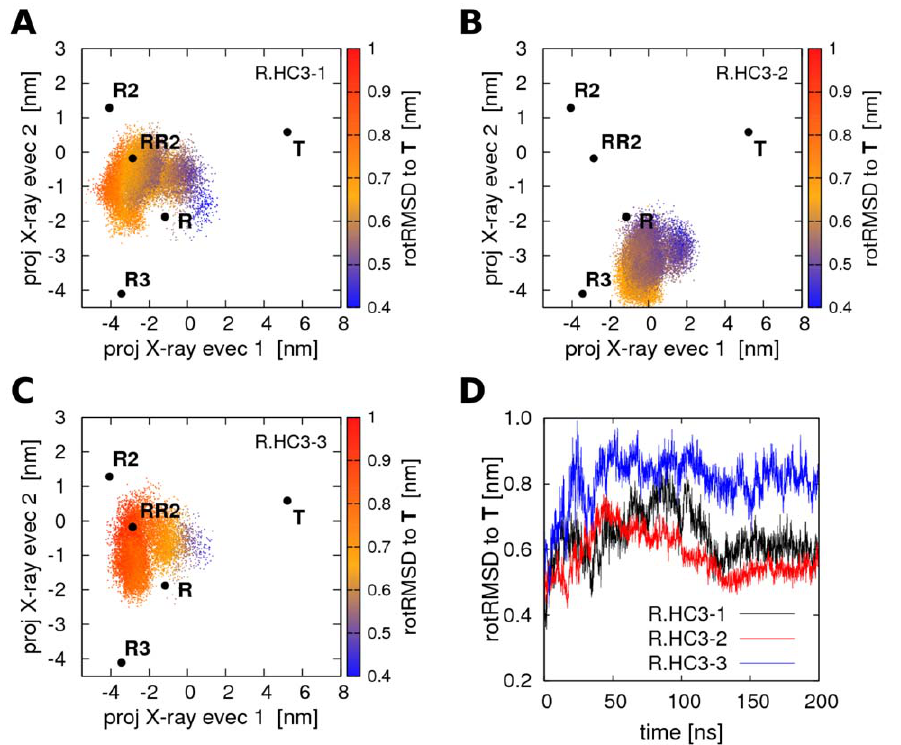
Figure 2. PCA projections of Hb simulations starting from R with protonated His( b )146. (A–C) Projections of Hb structures during simulations R.HC3-1 to R.HC3-3 on the two eigenvectors derived from a PCA of the T , R , and R2 X-ray structures. The T , R , R2 , RR2 , and R3 X-ray structures are indicated by black dots. The color encodes the rotRMSD with respect to the T X-ray structure. (D) rotRMSD of simulations R.HC3-1 to R.HC3-3 with respect to the T X-ray structure. No R R T transition occurs within simulation time, but simulations R.HC3-1 and R.HC3-3 approach the RR2 structure on a sub-100-nanosecond timescale.